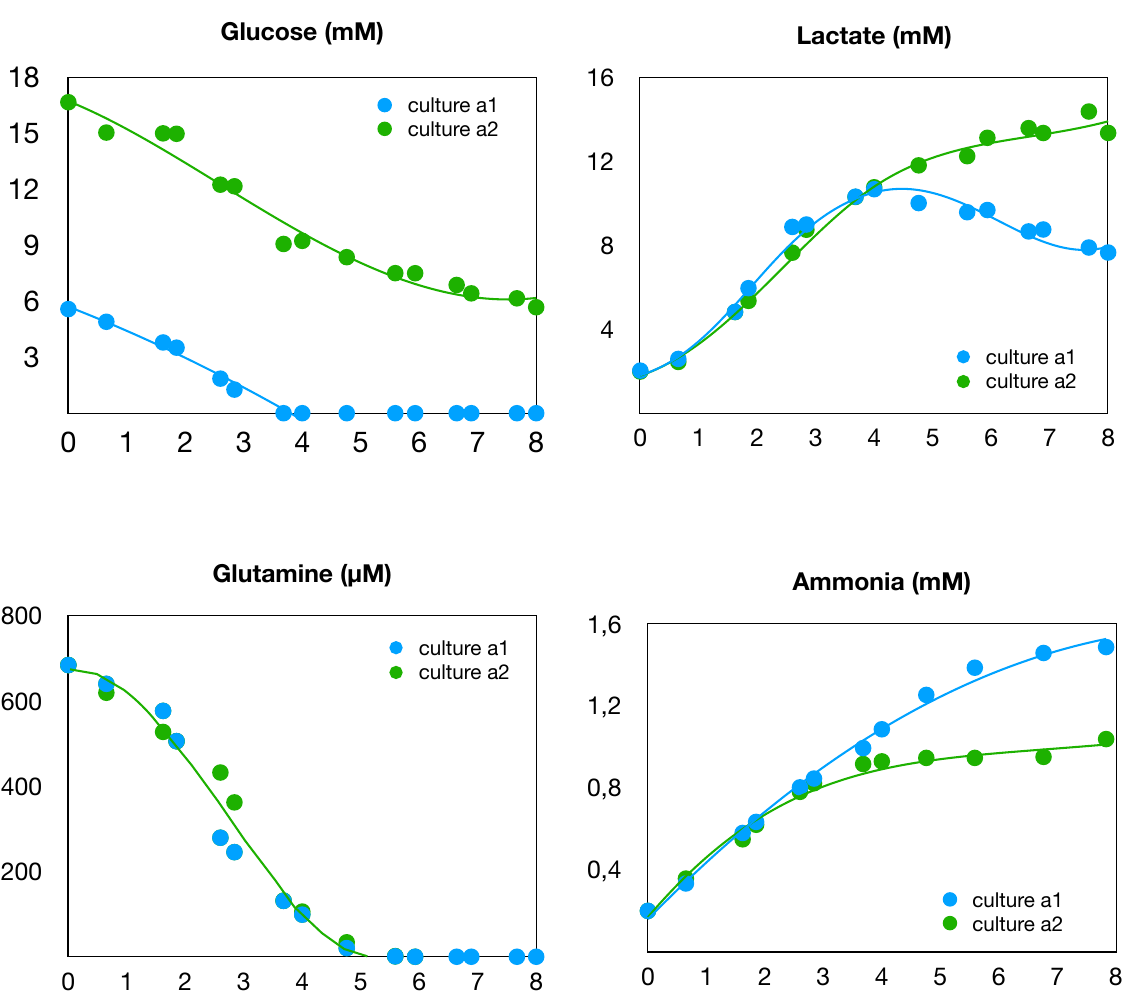
Figure 2. Time evolution of substrates and products of the central metabolism in cultures a1 and